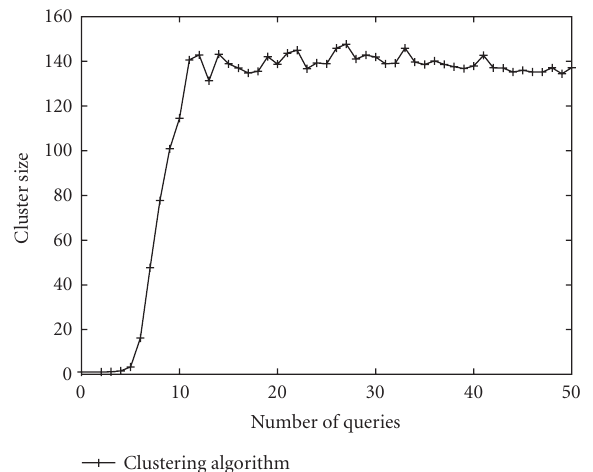
Figure 6: The interest association is a good metric to estimate in- terest similarity.